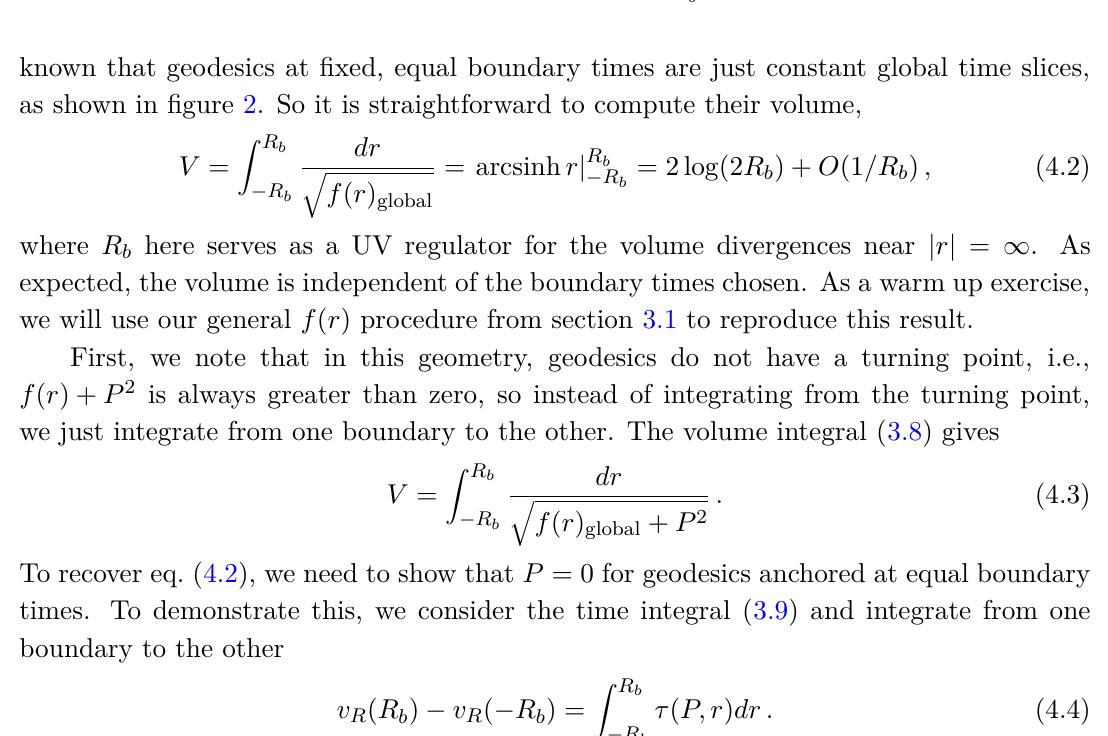
Figure 2. Penrose diagram for global AdS 2 . The geodesics in blue connect equal times on the two boundaries. The black dashed line is the cutoff surface r = R b (cid:29) 1